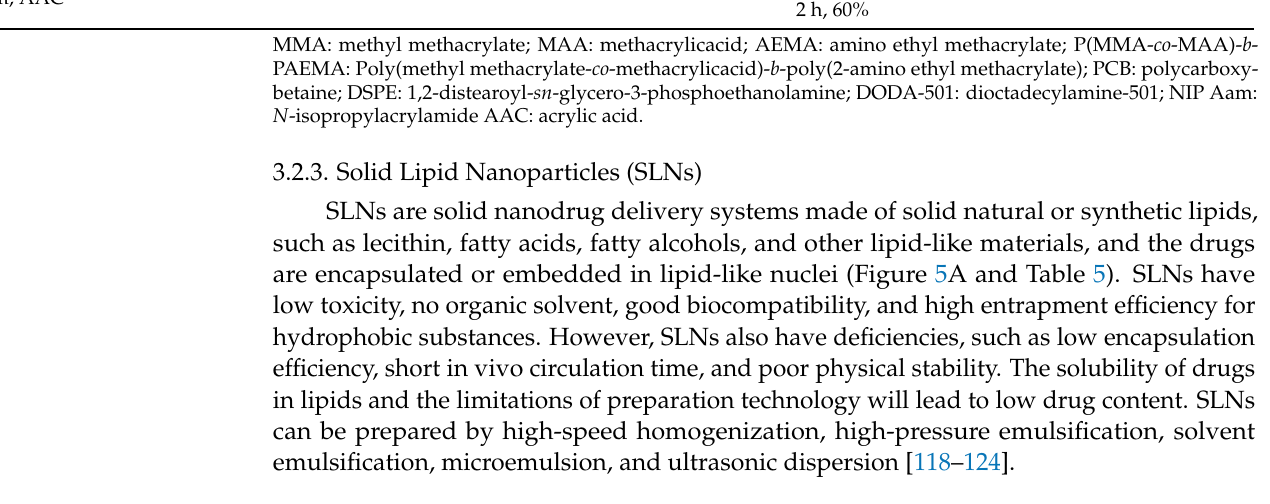
Table 5. Examples of SLNs as a nanostructure for oral insulin delivery